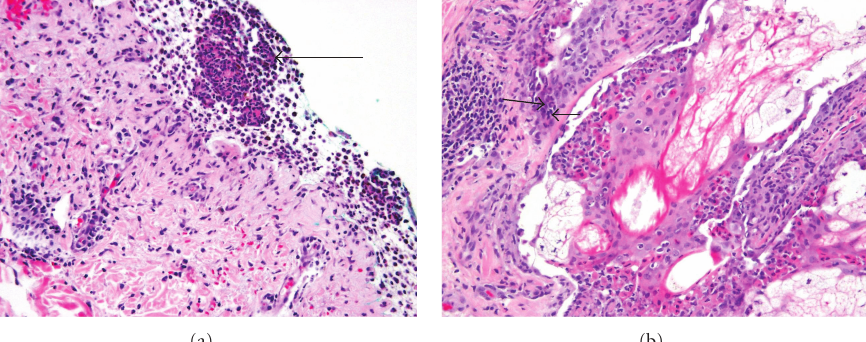
Figure 3: (a) Subepithelial abscess (arrow) on skin biopsy from left arm. (b) Necrotic infundibular epithelium with necrotic keratinocytes (arrows) on skin